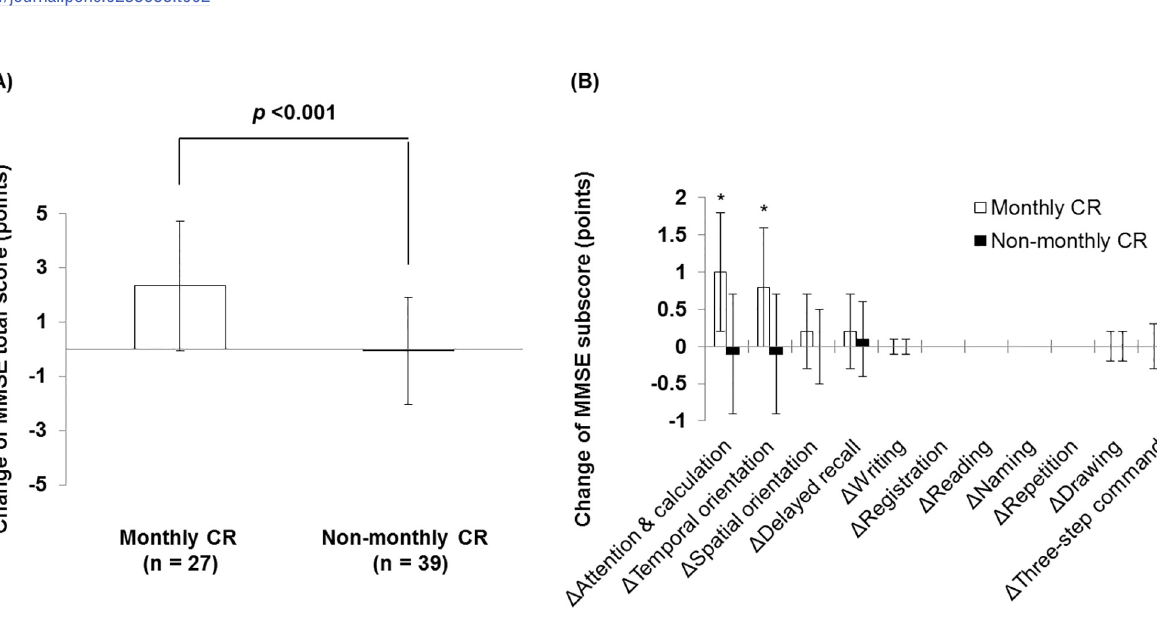
Fig 1. Change in the MMSE score during 6 months. (A) Change in the MMSE total score for 6 months between the monthly CR group and the non- monthly CR group. (B) Changes in the MMSE items for 6 months between the monthly CR group and the non-monthly CR group. CR, cardiac rehabilitation; MMSE, Mini-mental State